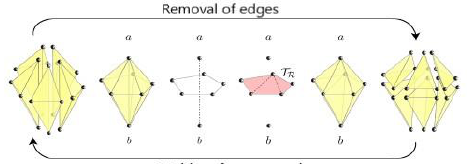
Figure 10 . Illustration of edge and polyhedral removal of a tetrahedron